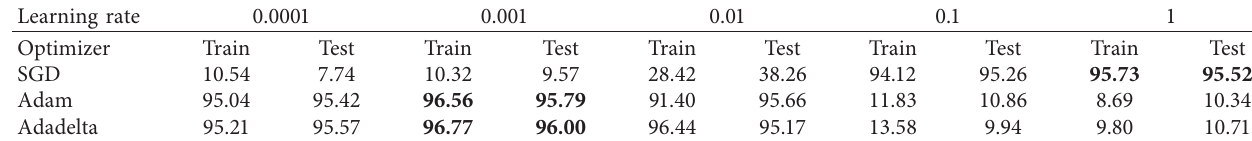
Table 5: Experimental results of different optimizers and learning rates.